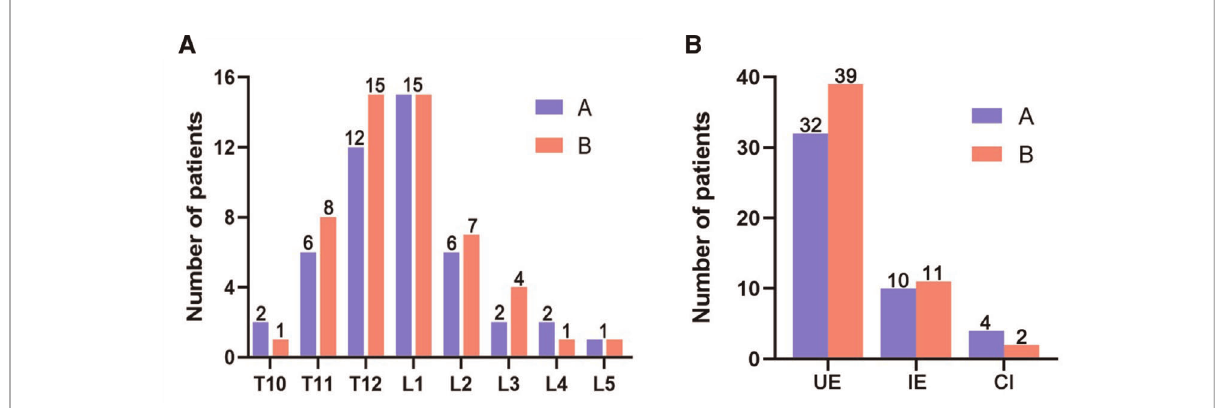
FIGURE 4 Injured vertebral segment and endplate injury site. ( A ) Comparison of vertebral injury segments between two groups. ( B ) Comparison of endplate injury site between two groups. UE: Only the upper endplate was damaged. IE: Only the Inferior endplate was damaged. CI: Both the upper endplate and the lower endplate were